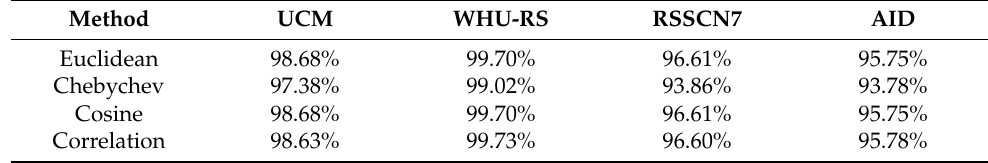
Table 4. Performance comparison of Euclidean distance and other similarity measurement